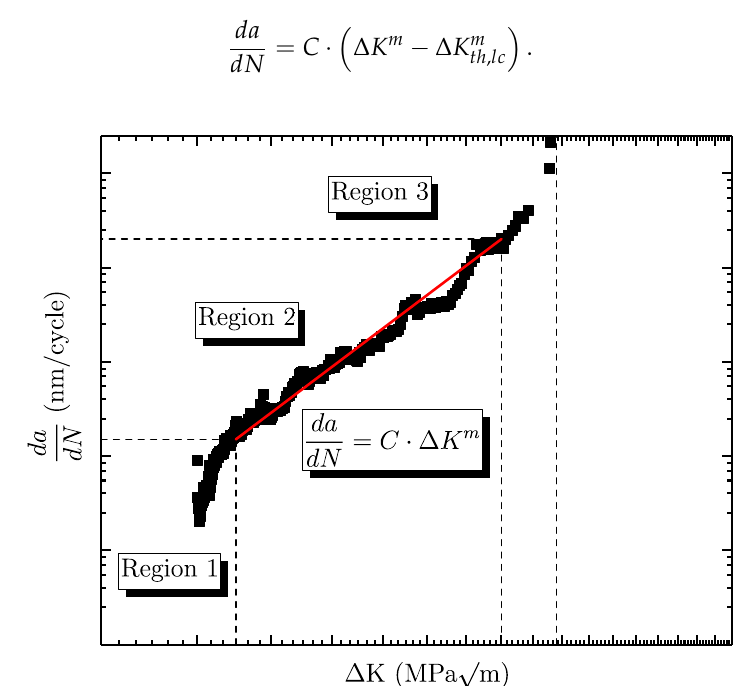
Figure 1. Representative crack–propagation curve with labelled